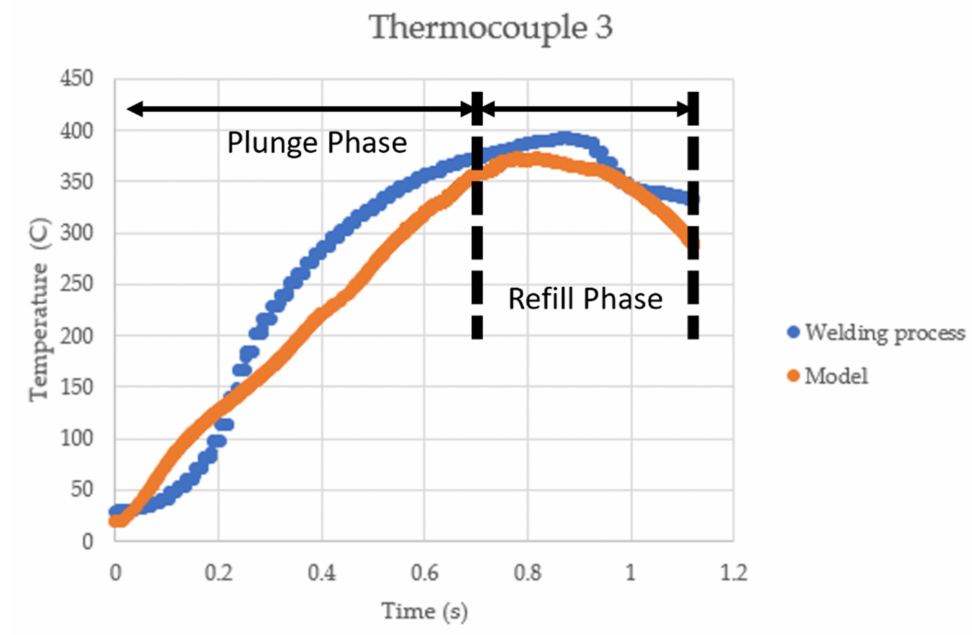
Figure 10. Thermal comparison for Thermocouple 3.